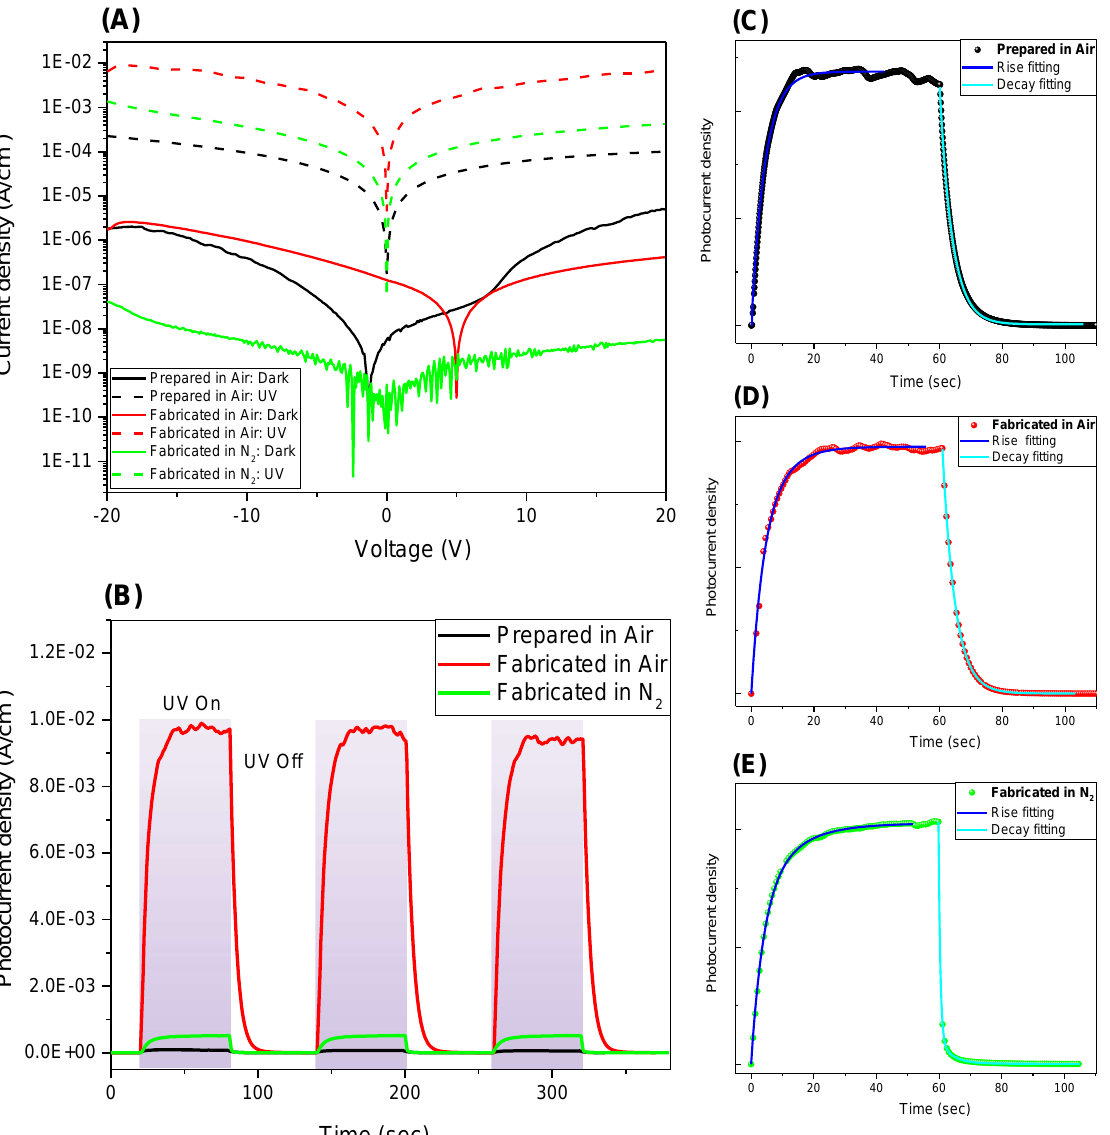
Figure 6: (A) I-V characteristics of ZnO NP films processed in nitrogen and air. (B) Photocurrent transients of the ZnO films. The devices were tested in the air at a voltage bias of 20 V. The photocurrent transients for devices processed in air and nitrogen are shown in (C), (D), and